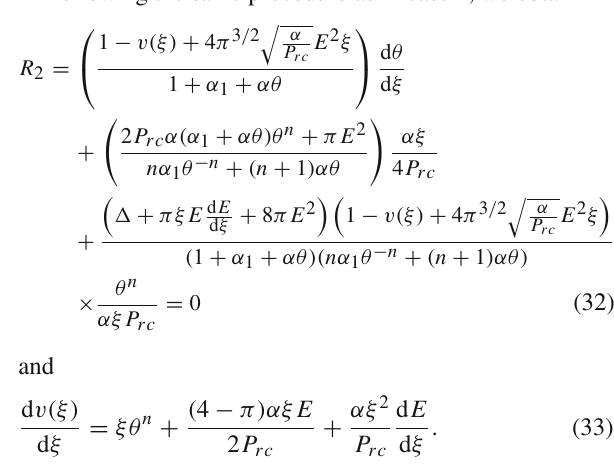
as a function of ξ for gc